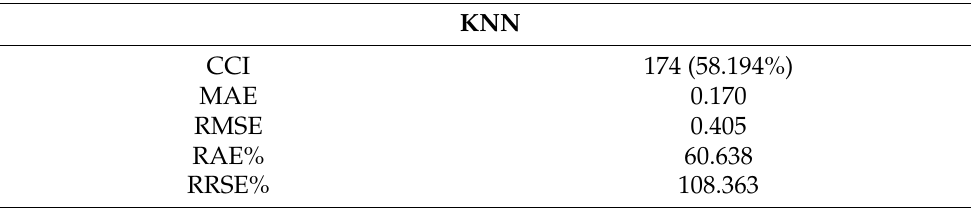
Table 5. CCI and Error Rates details achieved via KNN.